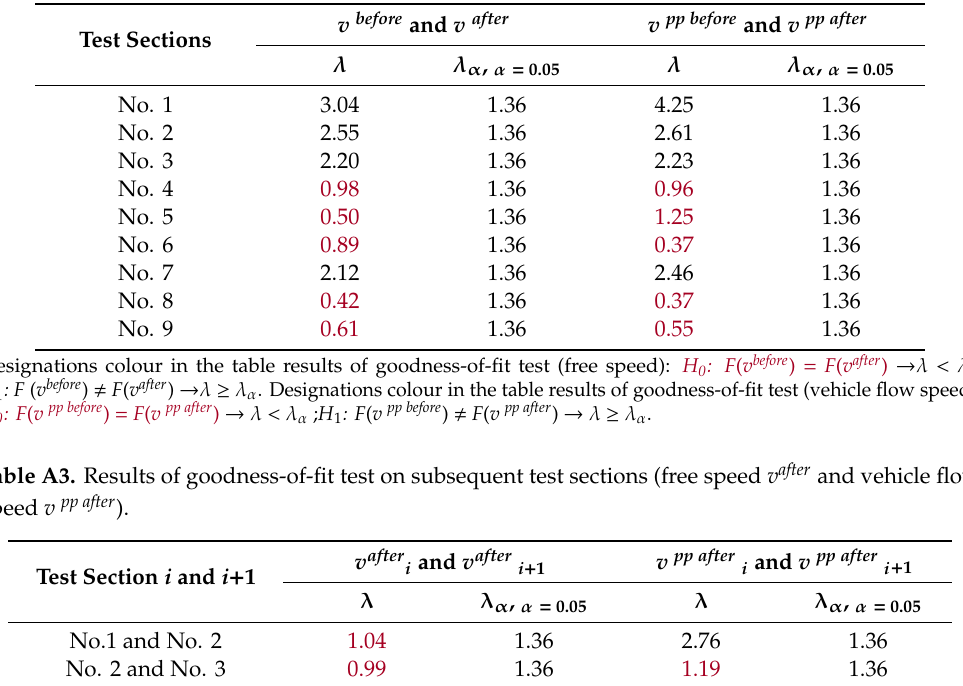
Table A2. Results of goodness-of-fit test on test sections (free speed v and vehicle flow speed v pp ).